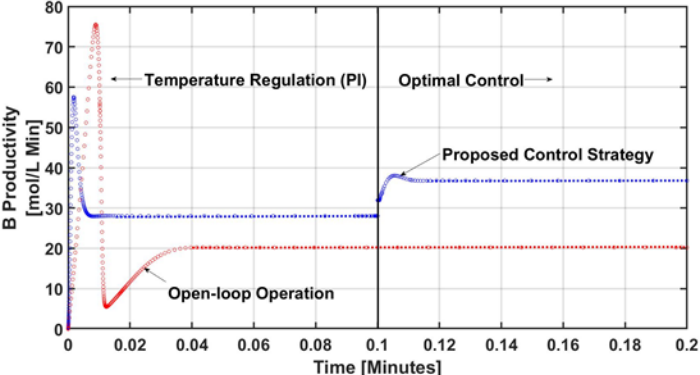
Figure 7. Open-loop and closed-loop dynamic behaviors of reactor productivity for compound B.